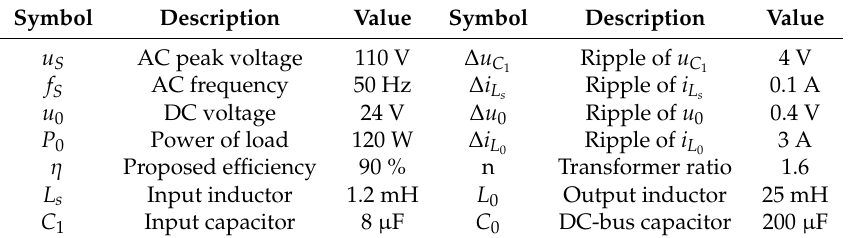
Table 1. Parameters inherent to the AC-DC converter to validate the proposed model.